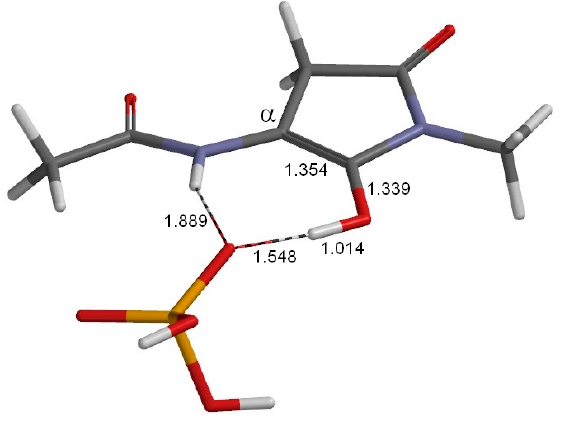
Figure 5. The geometry of the first enol minimum EN1 ( ϕ = − 165 ◦ , ψ = − 177 ◦ , χ 1 = 177 ◦ ). This is a complex between the enol form of the model compound and an H 2 PO 4 − ion, and lies between TS1 (Figure 4) and TS2 (Figure 6). Selected interatomic distances are shown in Å. Grey: carbon; white: hydrogen; blue: nitrogen; red: oxygen; orange: phosphorus.